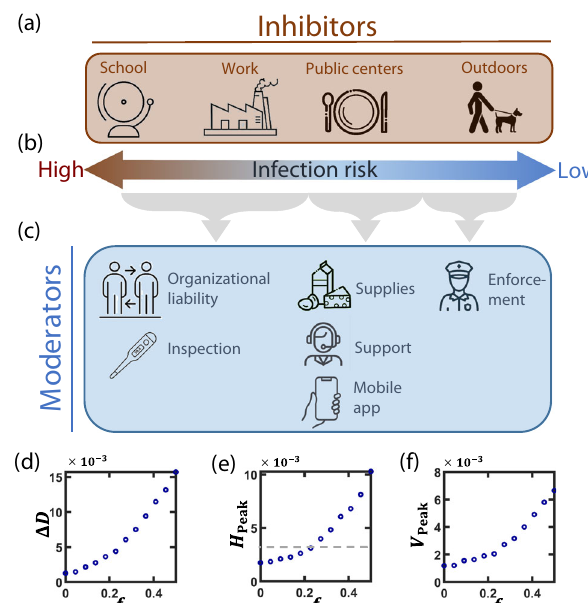
Fig. 7 Driving social conformity for alternating quarantine. a We identify four needs that inhibit potential cooperation: child care arrangements, work, purchasing supplies or services, and outdoor activities. b Infection risk is highest under extensive and continuous interactions, such as in school or at work, and least signi fi cant during open-air activities, such as strolling or exercising. We, therefore, focus on moderators mainly for the fi rst